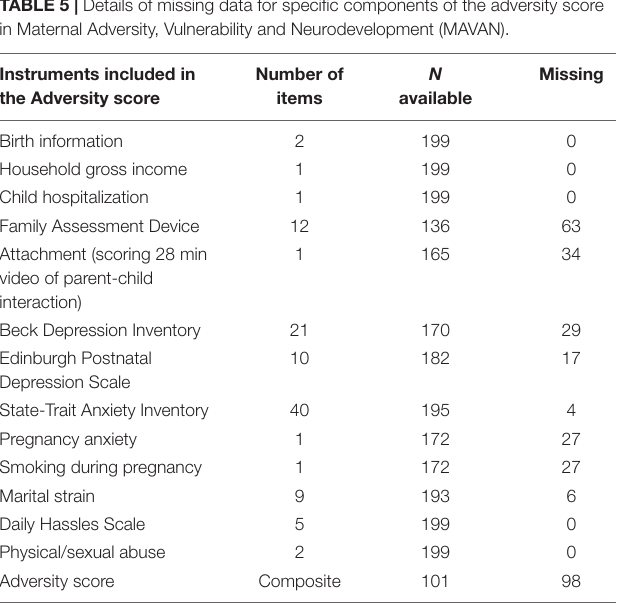
TABLE 5 | Details of missing data for specific components of the adversity score in Maternal Adversity, Vulnerability and Neurodevelopment (MAVAN).